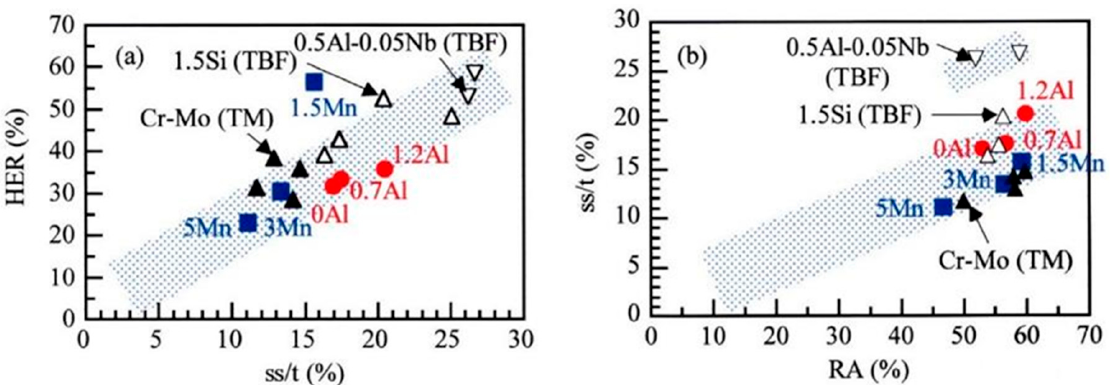
Figure 16. ( a ) Relationship between hole expansion ratio (HER) and a ratio of shear section length to sheet thickness ( ss / t ) and ( b ) relationship between ss / t and reduction of area (RA) in 0.20C-1.50Si-1.24Mn-0.20Cr-0.022Al-0.0028 (0Al), 0.20C-0.73Si-1.24Mn-0.19Cr-0.72Al-9.0027B (0.7Al), and 0.20C-0.20Si-1.24Mn-0.20Cr-1.22Al-0.0026B (1.2Al) TM steels ( ● ) [55,88], 0.2C-1.5Si-1.5Mn-(0-1.0)Cr-(0-0.2)Mo (Cr-Mo) TM steels ( ▲ ) [53], 0.2C-1.5Si-(1.5-5.0)Mn (1.5Mn, 3Mn, and 5Mn) M-MMn steels ( █ ) [59], 0.20C-1.50Si-1.50Mn-0.05Nb (1.5Si) TBF steel ( △ ) [51], and 0.2C-1.00Si-0.48Al-0.049Nb (0.5Al-0.05Nb) TBF steels ( ▽ ) [14]. ( a ) and ( b ) are produced based on references [51,53,55,59,88].